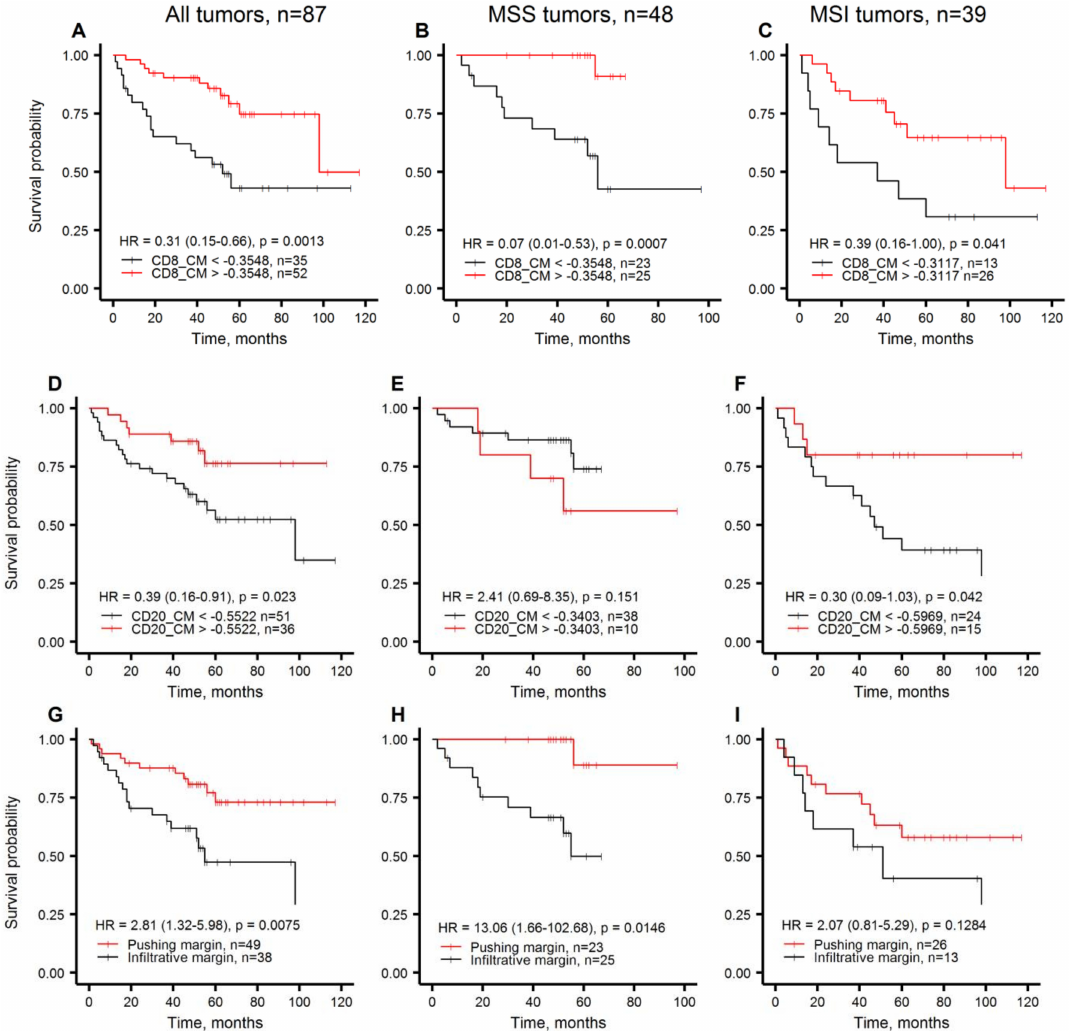
Figure 1. Kaplan-Meier plots representing overall survival probabilities obtained by Immunogradient and histology indicators in all tumors, MSS tumors, MSI tumors, respectively. ( A – C ): CM for CD8 + cell density in the IZ; ( D – F ): CM for CD20 + cell density in the IZ; ( G – I ): tumor growth pattern. The features that revealed significant patient stratification in univariate analyses ( p < 0.05, Table 3) were tested for their independent prognostic value by multiple Cox regression (Table 4). A strong prognostic model (Model#1, LR: 23.03; p < 0.0001) was obtained with high CM for CD8 + and CD20 + cell densities predicting longer patient OS, and infiltrative tumor growth pattern independently associated with worse patient survival; an example of independent indicators’ estimates in an individual CRC case is presented in Figure